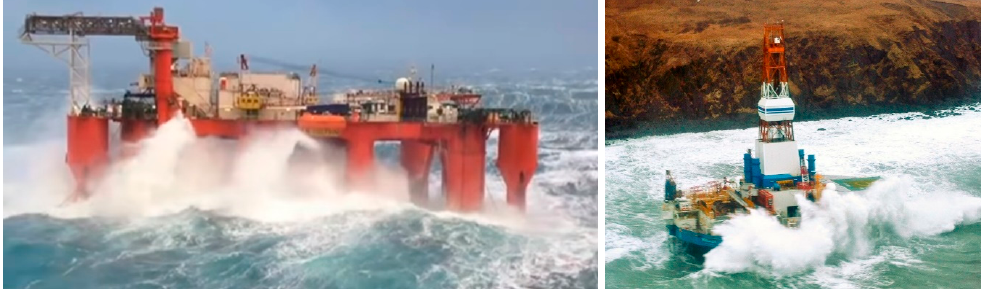
Figure 1. Structural damage caused by slamming in extreme conditions.